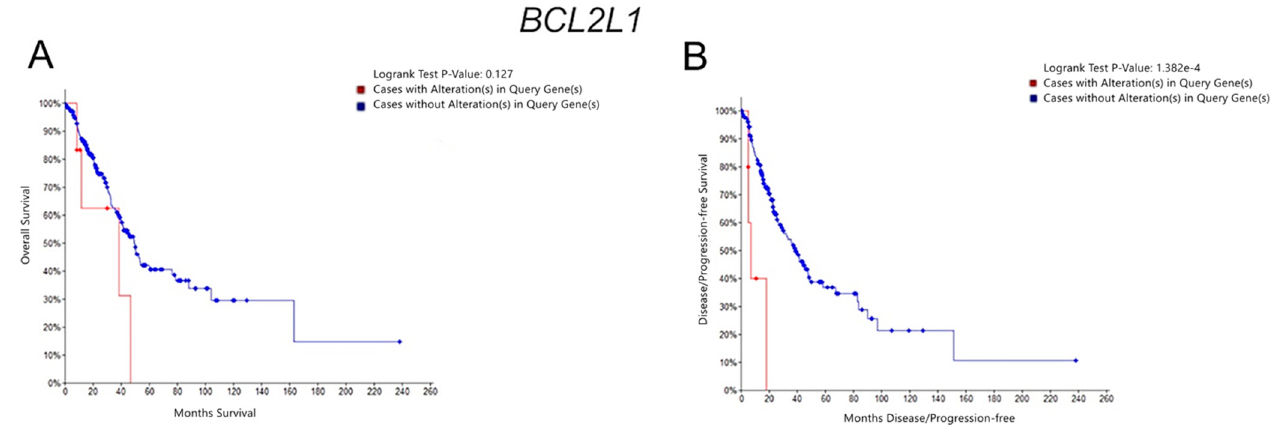
Figure 8. ( A ): Overall Survival Kaplan–Meier Estimate of LUAD cancer patients with BCL2L1 gene amplification (red) or without (blue). ( B ): Disease/Progression-free Kaplan–Meier Estimate in LUAD cancer patients with BCL2L1 gene amplification (red) and without (blue). Graph from Oncomine.org site using TCGA cancer data [327–329].